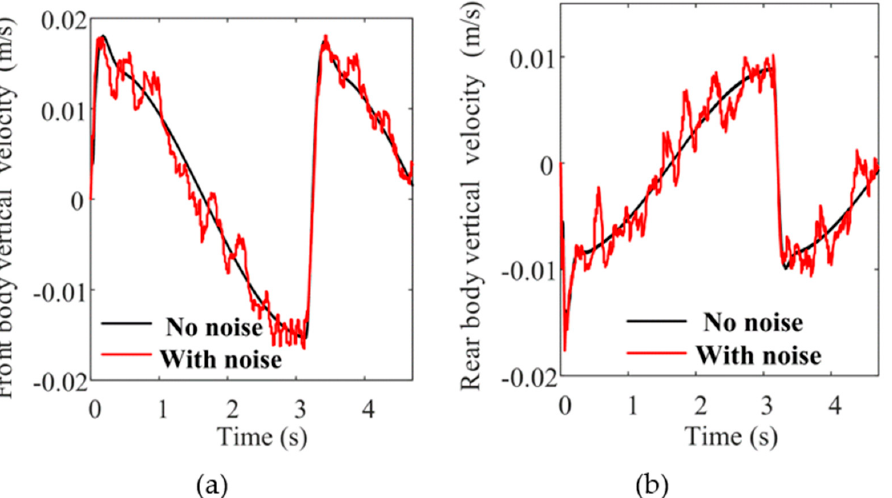
Figure 5. Body vertical velocity changes. ( a ) Front body vertical velocity; ( b ) Rear body vertical velocity.